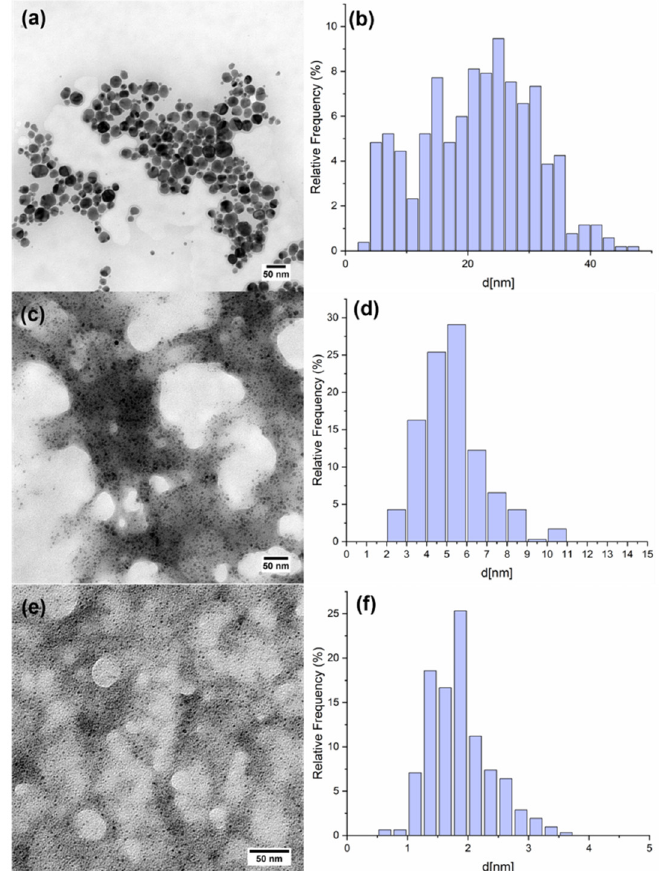
Figure 1. On the left: TEM images of ( a ) Pd NPs, ( c ) Rh NPs and ( e ) Ru NPs and the corresponding histogram distribution of the diameter on the right in the ( b , d , f ) panel.